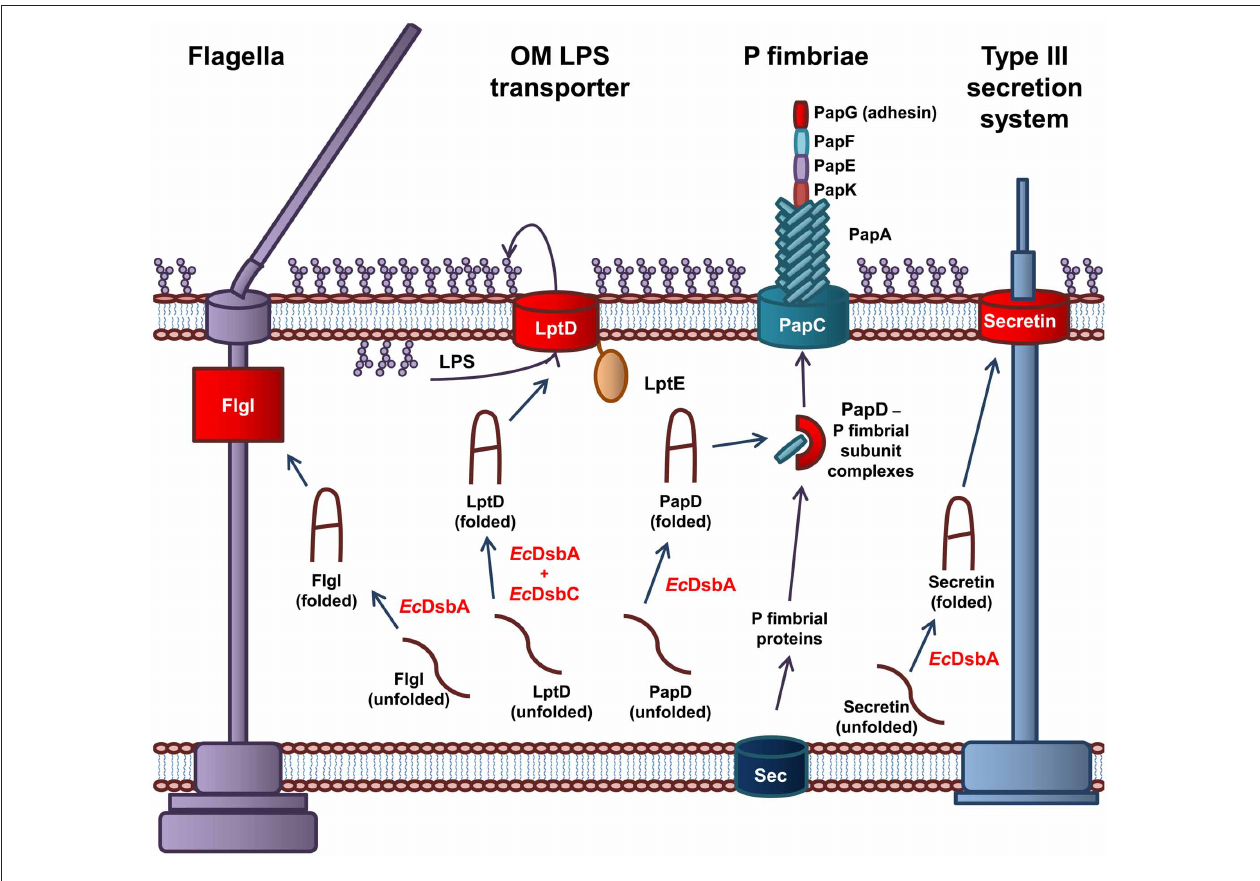
FIGURE 2 | The role of Ec DsbA and Ec DsbC in biosynthesis of virulence factors in E. coli . EcDsbA catalyzes the formation of a disulfide bond in the FlgI P-ring motor protein required for assembly of functional flagella. Both Ec DsbA and Ec DsbC are required for the correct folding of the OMP LptD, which associates with the OM lipoprotein, LptE, to form the OM LPS transporter. Ec DsbA catalyzes the formation of a disulfide bond in the PapD